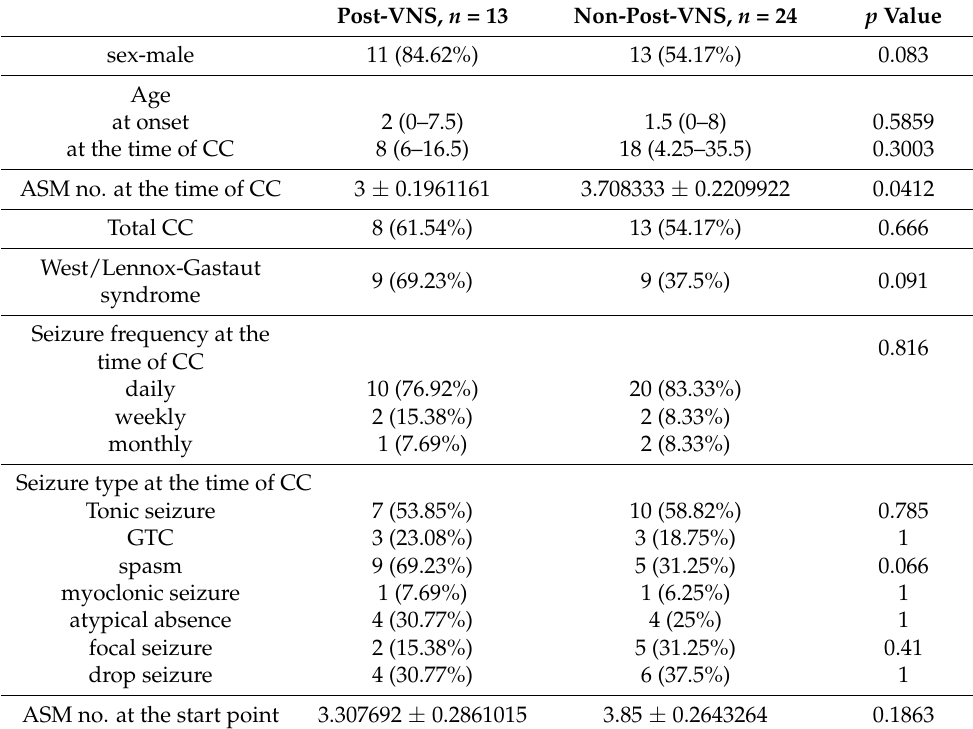
Table 1. Patient